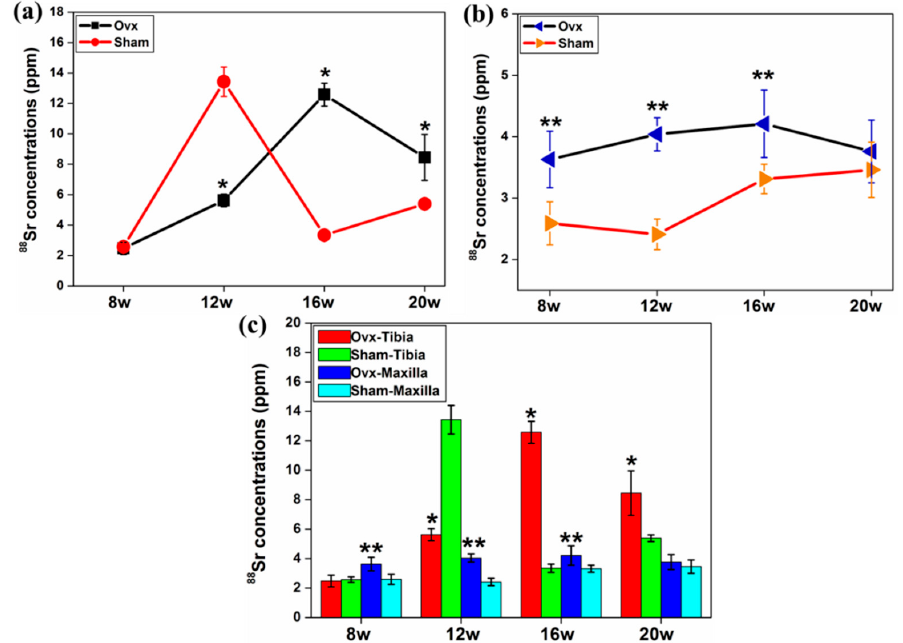
Figure 5. ( a ) The average concentrations of 88 Sr increased in Ovx tibia at weeks 16 and 20 post surgery; ( b ) the concentration of 88 Sr was higher in Ovx maxilla at all time points; and ( c ) generally, there was a higher concentration of 88 Sr in the maxilla from the Ovx group compared to the sham group at all time points post-surgery. *: Significant difference ( p < 0.05) between Ovx-tibia and Sham-tibia; **: Significant difference ( p < 0.05) between Ovx-maxilla and Sham-maxilla.